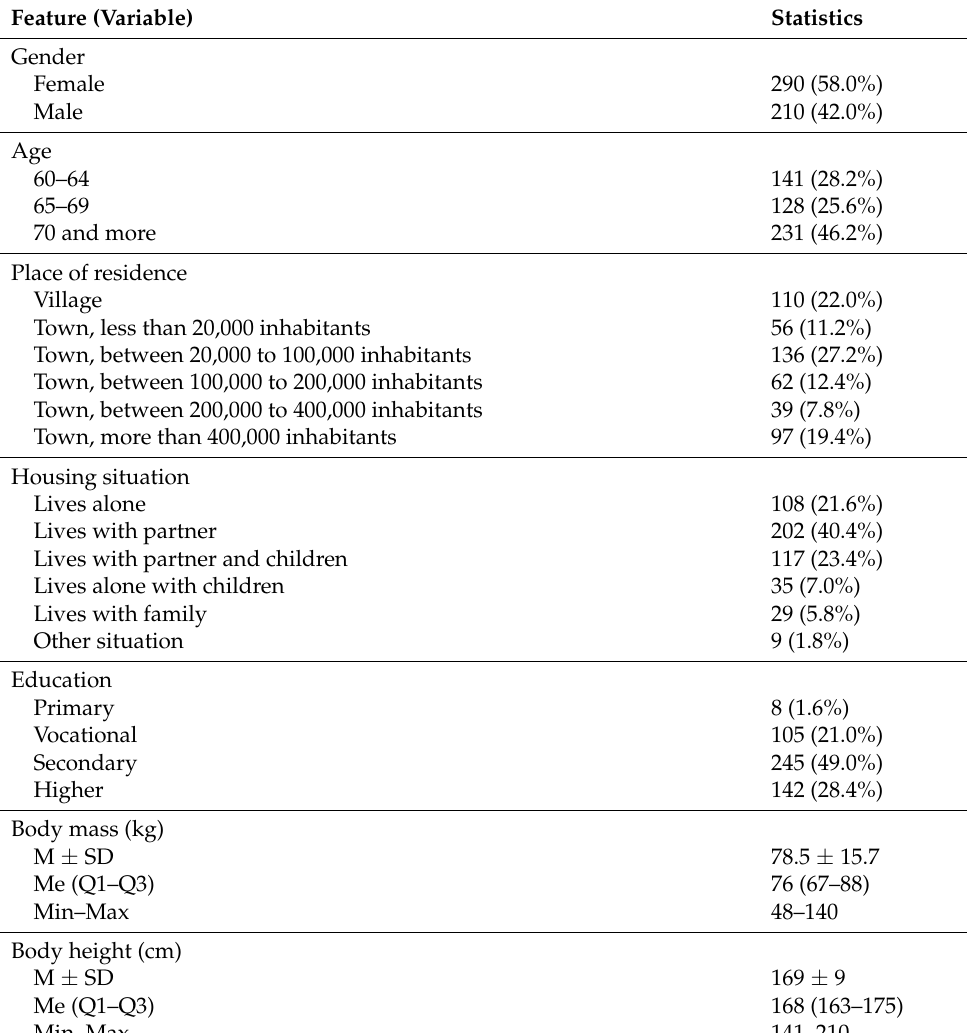
Table 1. General, clinical and psychological characteristics of the surveyed